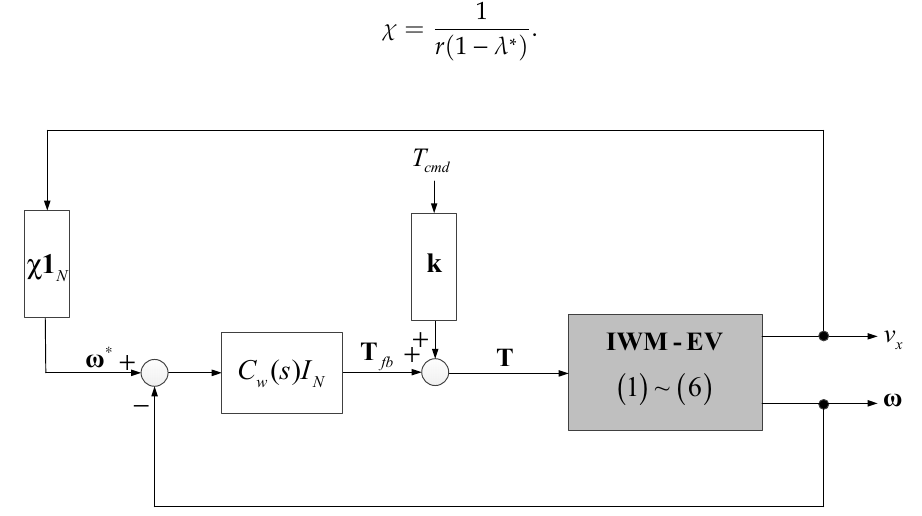
Figure 4. Motivating example: Anti-slip control by wheel velocity control. (Notice: the block diagram is generalized from the original diagram in [22]).